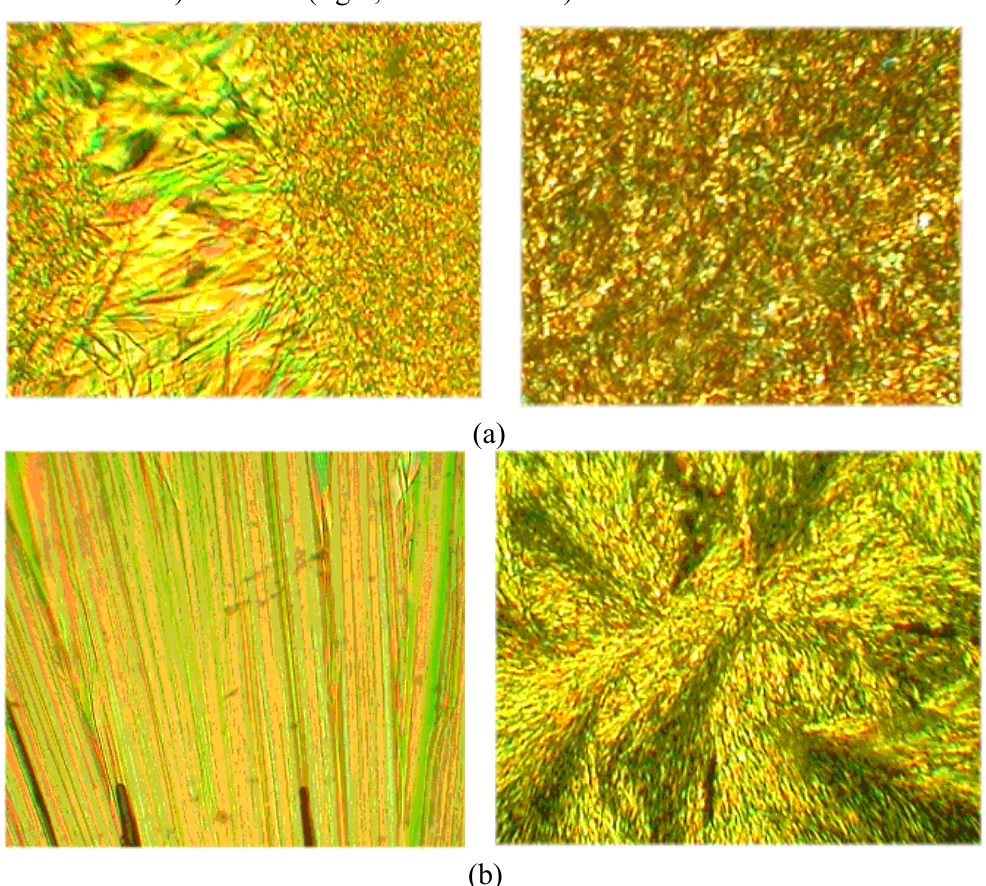
Figure 7. (a) Photomicrographs of the optical textures of mesophases obtained for the symmetrical AT1 (left, seen at 136 ° C) and AT2 (right, seen at 154 ° C). (b) Photomicrographs of the optical textures of crystals obtained for the symmetrical AT1 (left, seen at 133 ° C) and AT2 (right, seen at 153 °